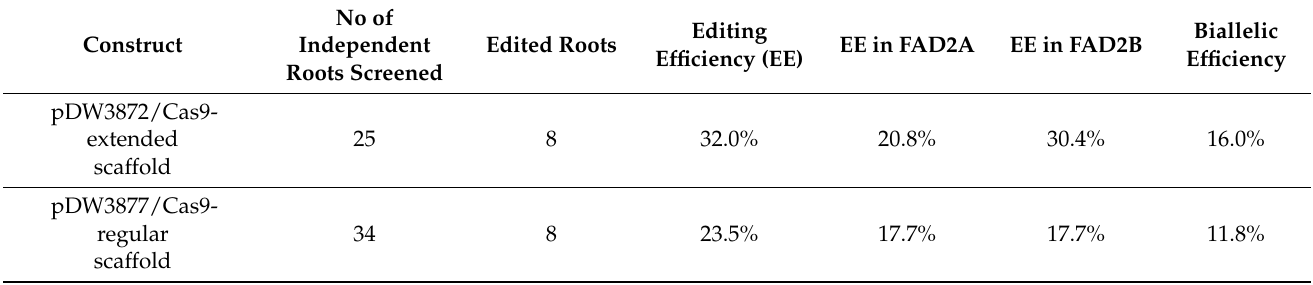
Table 1. Editing efficiency at the coding region of AhFAD2A and AhFAD2B